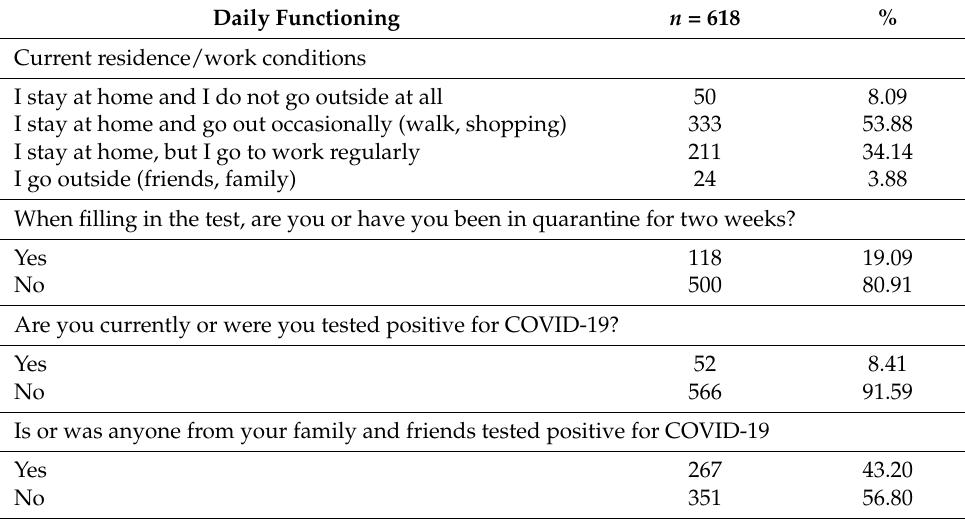
Table 2. Daily functioning during the